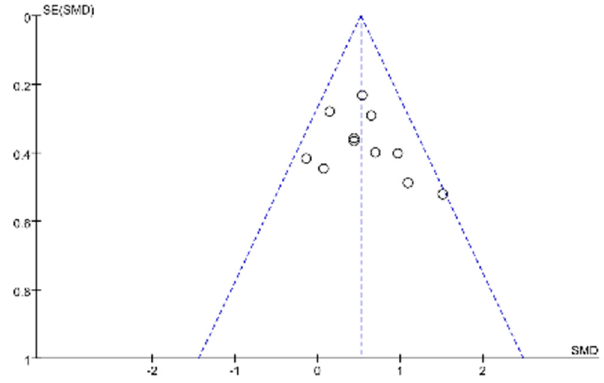
Figure 6. Funnel